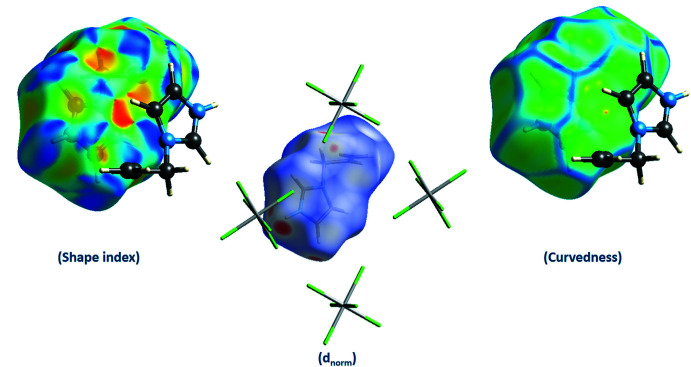
View of the Hirshfeld surfaces for (C6H9N2)2[SnCl6] mapped over shape-index, d
norm and curvedness.